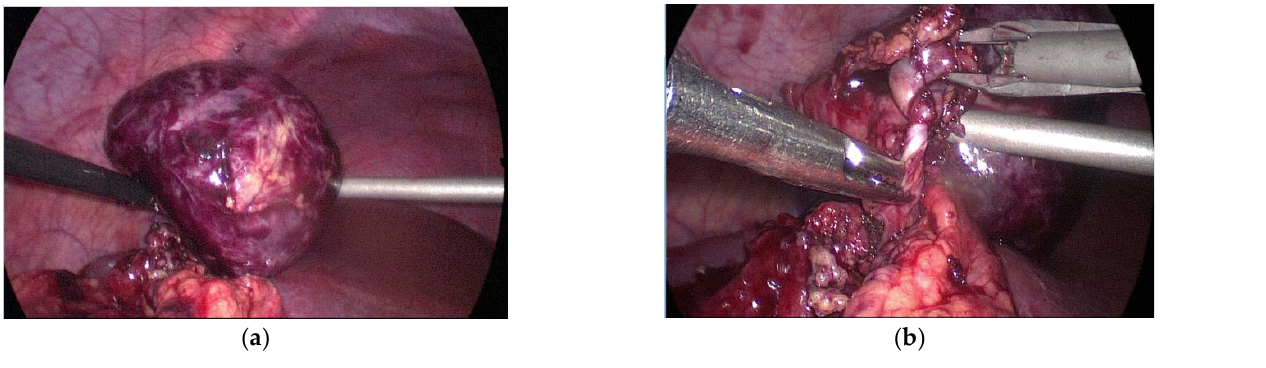
Figure 5. Laparoscopy showing: ( a ) a 5 cm × 5 cm intra-abdominal tumor beneath the liver—a suspected spleen; ( b ) twisted feeding vessels are also observed without ligaments connected around them.